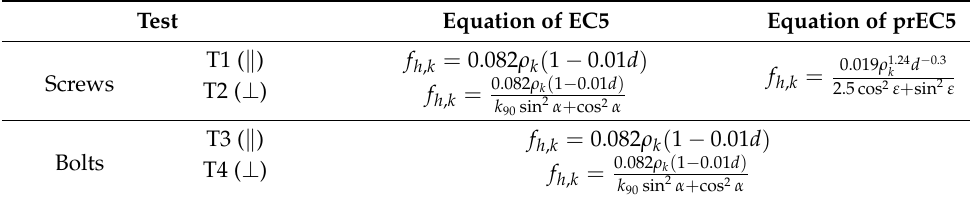
Table 3. Equations provided by EC5 and prEC5 to determine the embedment strength.